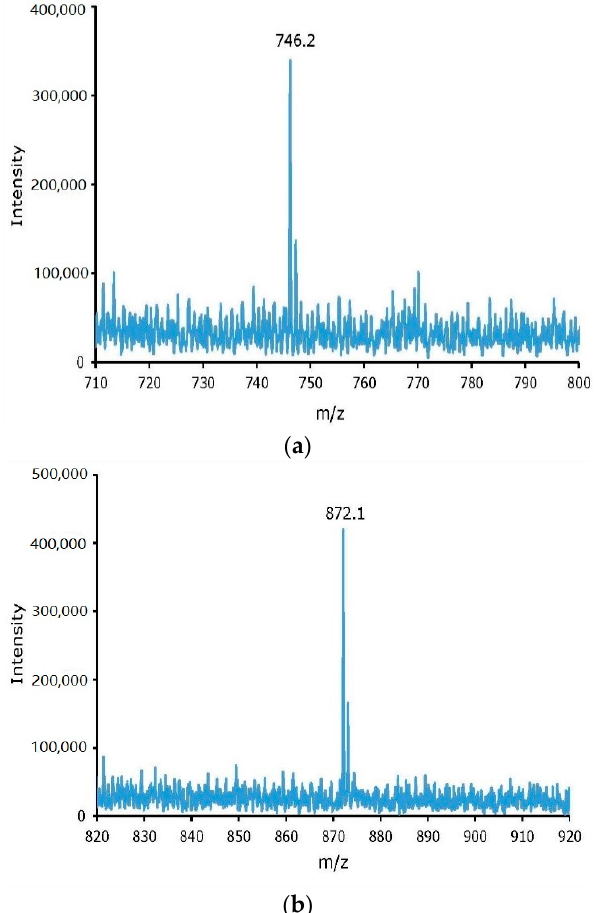
Figure 3. ESI mass spectra of two HPLC chromatogram peaks collected from the non-radioactive iodine labeling reaction mixture of cyclo Arg-Gly-Asp-d-Tyr-Lys